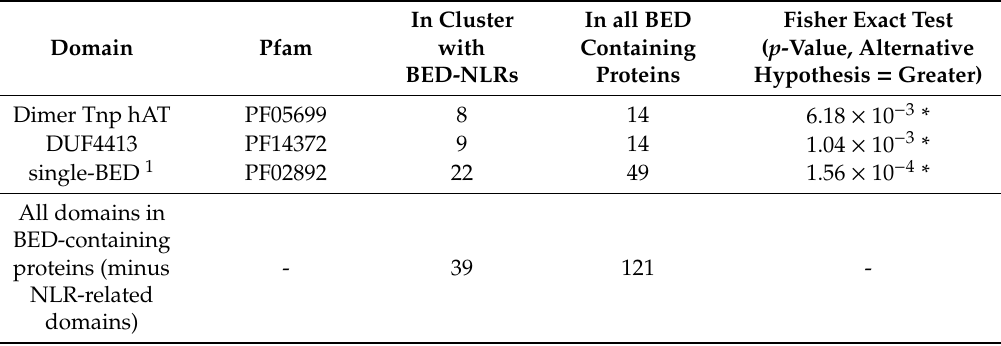
Table 4. Conserved domain enrichment analysis in BED-containing proteins whose BED domains share similarities with BED domains from BED-NLRs in the Pooideae (Fisher’s exact test with alternative hypothesis = greater). Domain Pfam